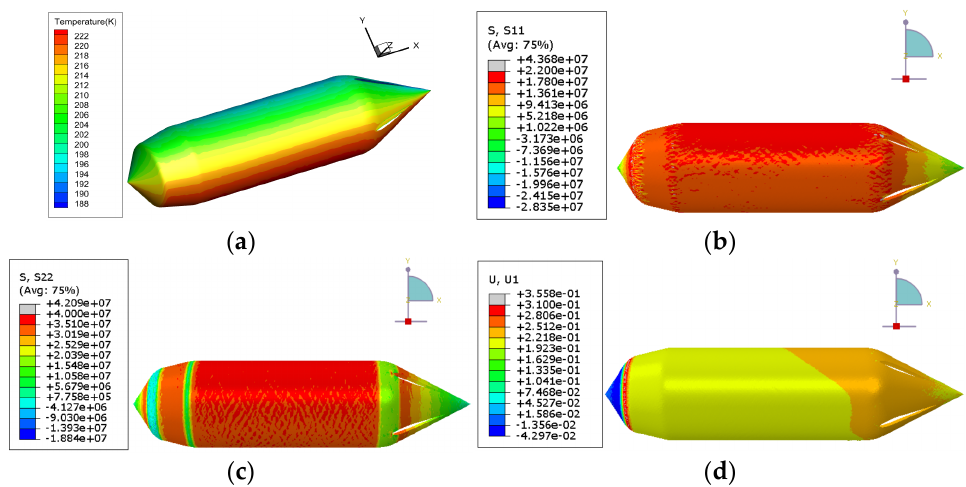
Figure 10. Simulation results at 12:00 a.m. ( a ) Temperature distribution at 12:00 a.m. ( b ) S11 stresses at 12:00 a.m. (units:Pa) ( c ) S22 stresses at 12:00 a.m. (units:Pa) ( d ) U1 deformation at 12:00 a.m. (units:m)